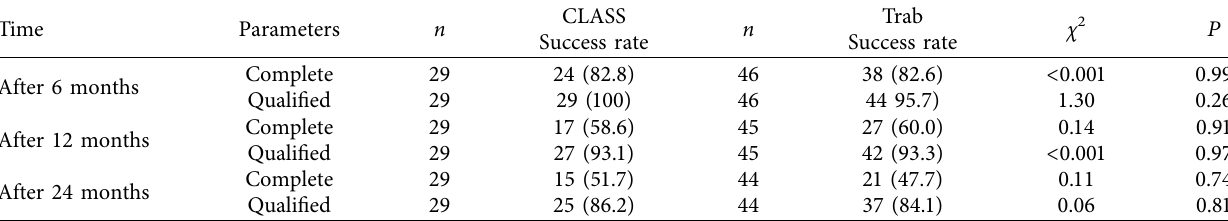
Table 4: Success rate over time between the two groups n (%).